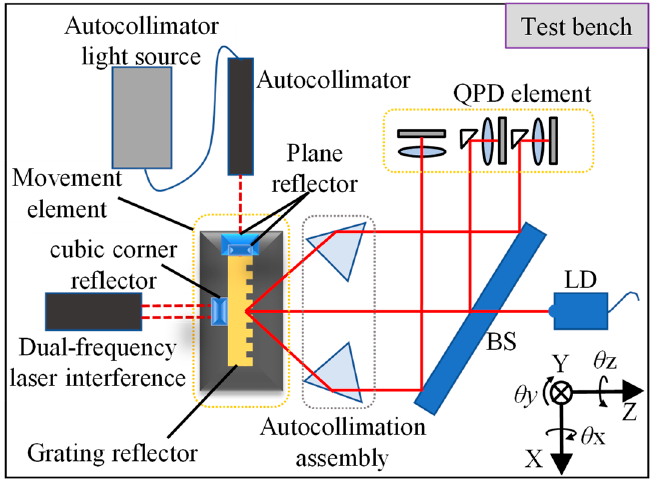
Figure 3. Schematic figure of test bench.